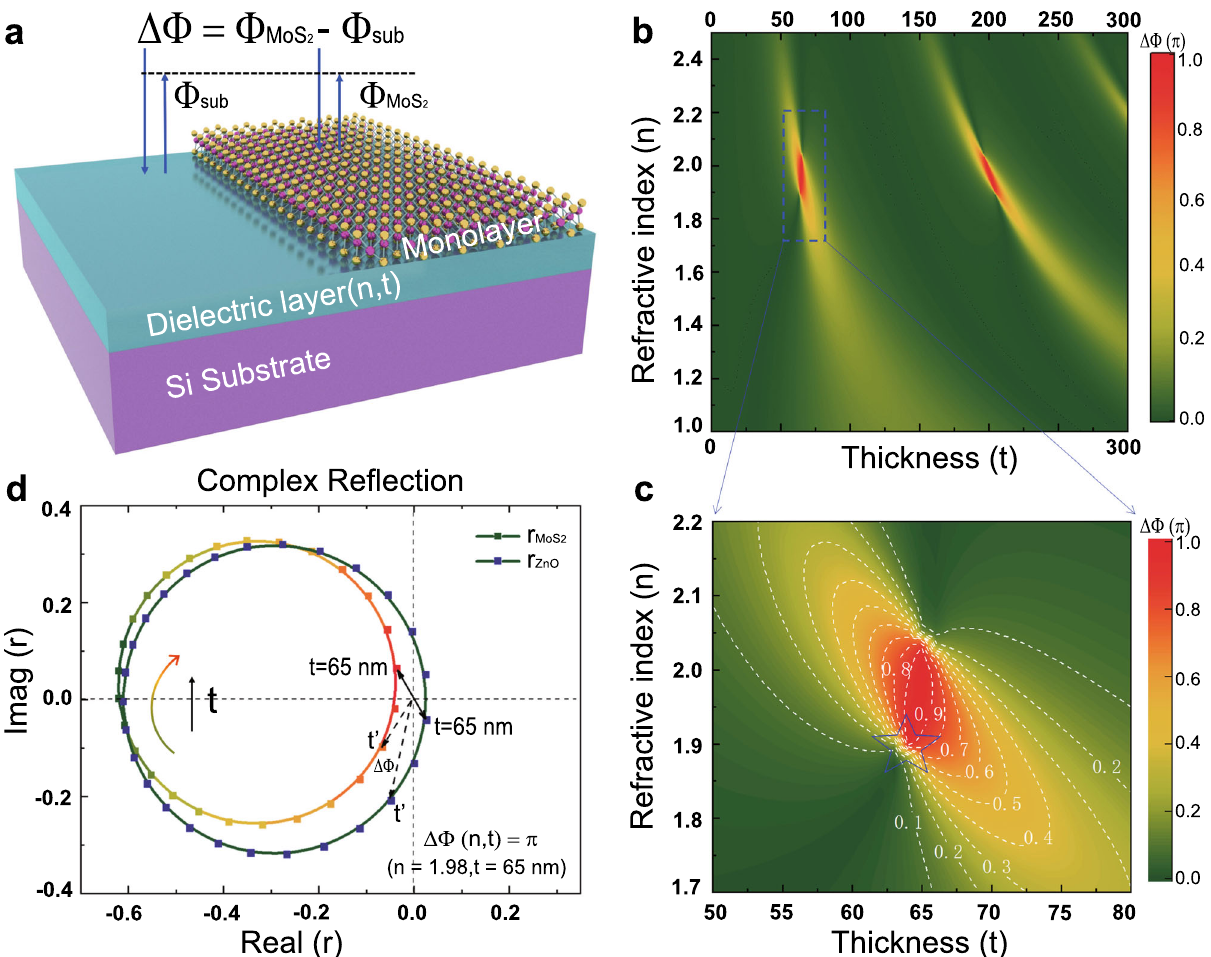
Fig. 1 Principle of loss-assisted giant phase shift of π arising from a monolayer MoS 2 sheet. a Schematic illustration of the phase shifts ( Δ∅ ) of the re fl ected light between a MoS 2 sheet ( ; MoS ) and a Si substrate ( ϕ sub ) coated by a uniform dielectric fi lm with different refractive indices ( n ) and fi lm 2 thicknesses ( t ). b Simulation results of the loss-assisted phase modulation dependence on the thickness ( t ) and refractive index ( n ) of the dielectric layer. c Zoom-in view of the blue dashed region in ( b ). White dashed lines are the iso-phase contours. The singular point of the iso-phase contours marked by the blue star represents the critical coupling point at which the system transfers between the over-coupling and under-coupling states, thus leading to an abrupt phase change in the re fl ected light. d Phasor diagrams of the complex re fl ection coef fi cient for the cases with (colourful circle) and without (olive green circle) a 0.67 nm-thick MoS 2 sheet on the ZnO-Si substrate when sweeping the thickness of the ZnO sheet from 0 to 130 nm. A π phase difference can be reached at the optimal ZnO fi lm thickness of 65